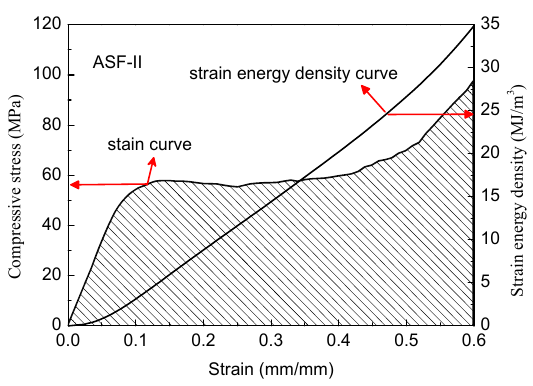
Figure 13. Stress–strain curve and strain energy density curve of ASF-II.